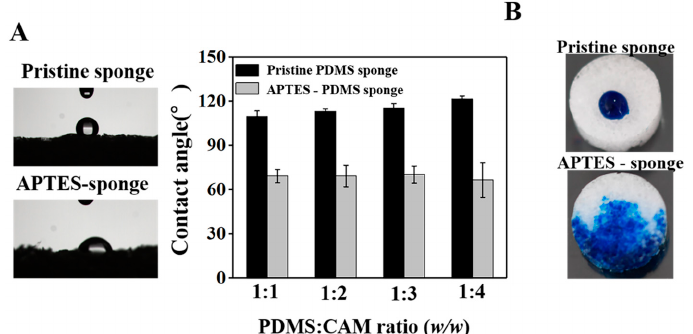
Figure 1. Wettability of the PDMS sponges. ( A ) Contact angle on the PDMS sponges before and after APTES modification and ( B ) water adsorbed by PDMS sponges. 100 µL diluted food color ( blue ) was cast on PDMS sponges. Pictures were taken 10 seconds after liquid casting. APTES: (3-Aminopropyl) triethoxysilane.